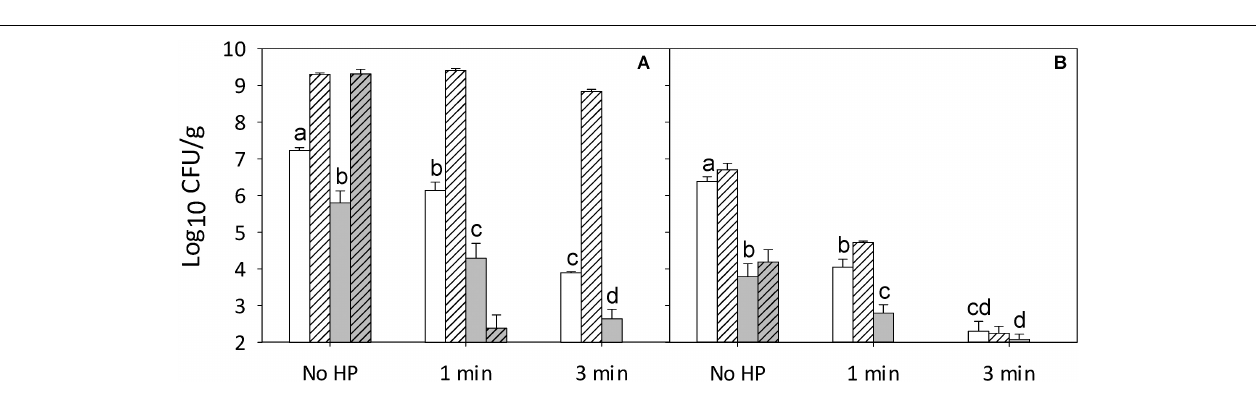
FIGURE 4 | Effect of pressure and RTE meat microbiota on survival and post-pressure growth of L. monocytogenes and RTE meat microbiota on ham treated with 0.02 N HCl (solvent control) or an equivalent volume of a nisin preparation in 0.02 N HCl to achieve a concentration of 2 µ g/cm 2 , corresponding to 0.05 µ g/cm 2 pure nisin. Shown are total cell counts (A) on non-selective agar and cell counts of L. monocytogenes (B) enumerated on selective PALCAM (B) agar. Samples were treated at 500 MPa for 1 or 3 min without (white) or with (gray) nisin. Cell counts ere enumerated immediately after pressure treatment (solid columns) and after storage for 4 weeks at 4 ◦ C (hatched columns). Data are shown as means ± standard deviations of triplicate independent experiments. Treatment means (solid columns) within each panel with different letters are significantly different ( P < 0.05). The interception point of abscissa and ordinate represents the highest detection